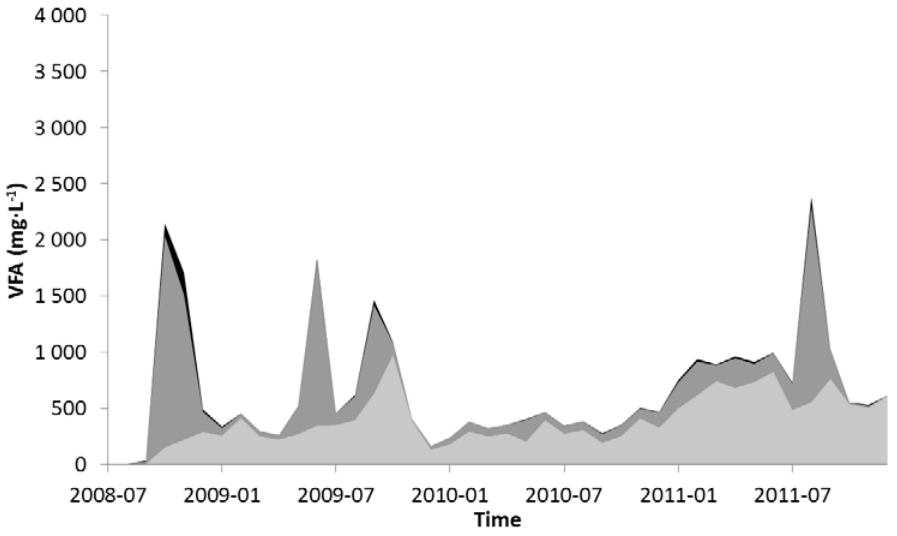
Figure 2. Mean monthly concentration of volatile fatty acids (VFA) at the Norrköping biogas plant, 2008–2011. Acetic acid (■) and propionic acid (■) are presented separately, while the total concentration of residual acids (C4–C7) are presented together